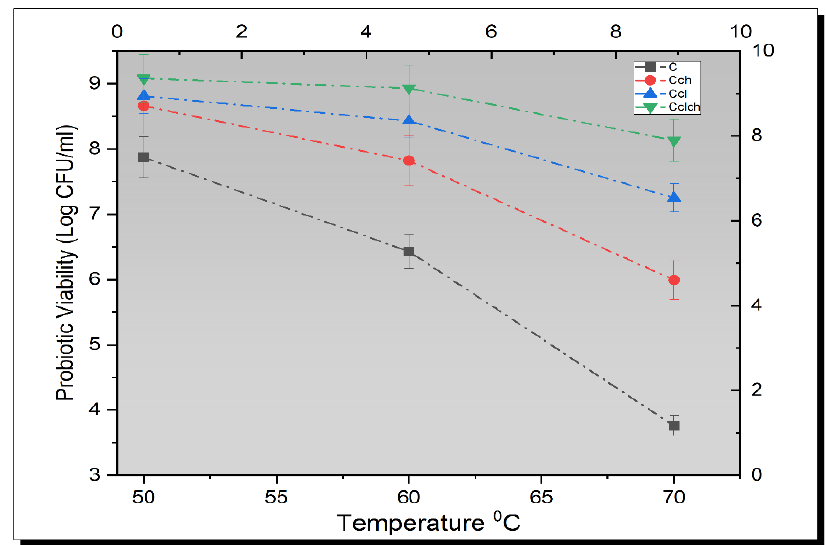
Figure 5. Effect of free (unencapsulated) and encapsulated (chitosan and cellulose) L. plantarum on probiotic viability in Kefir at elevated temperatures (50 °C, 60 °C, and 70 °C) compared with control. Each line represents mean value for viability of treatments. Kf (un-encapsulated probiotics/free), Kch (Kefir containing L. plantarum encapsulated with chitosan), Kcl (Kefir containing L. plantarum encapsulated with cellulose), and Kch-cl (Kefir containing L. plantarum with cellulose–chitosan hybrid cells).